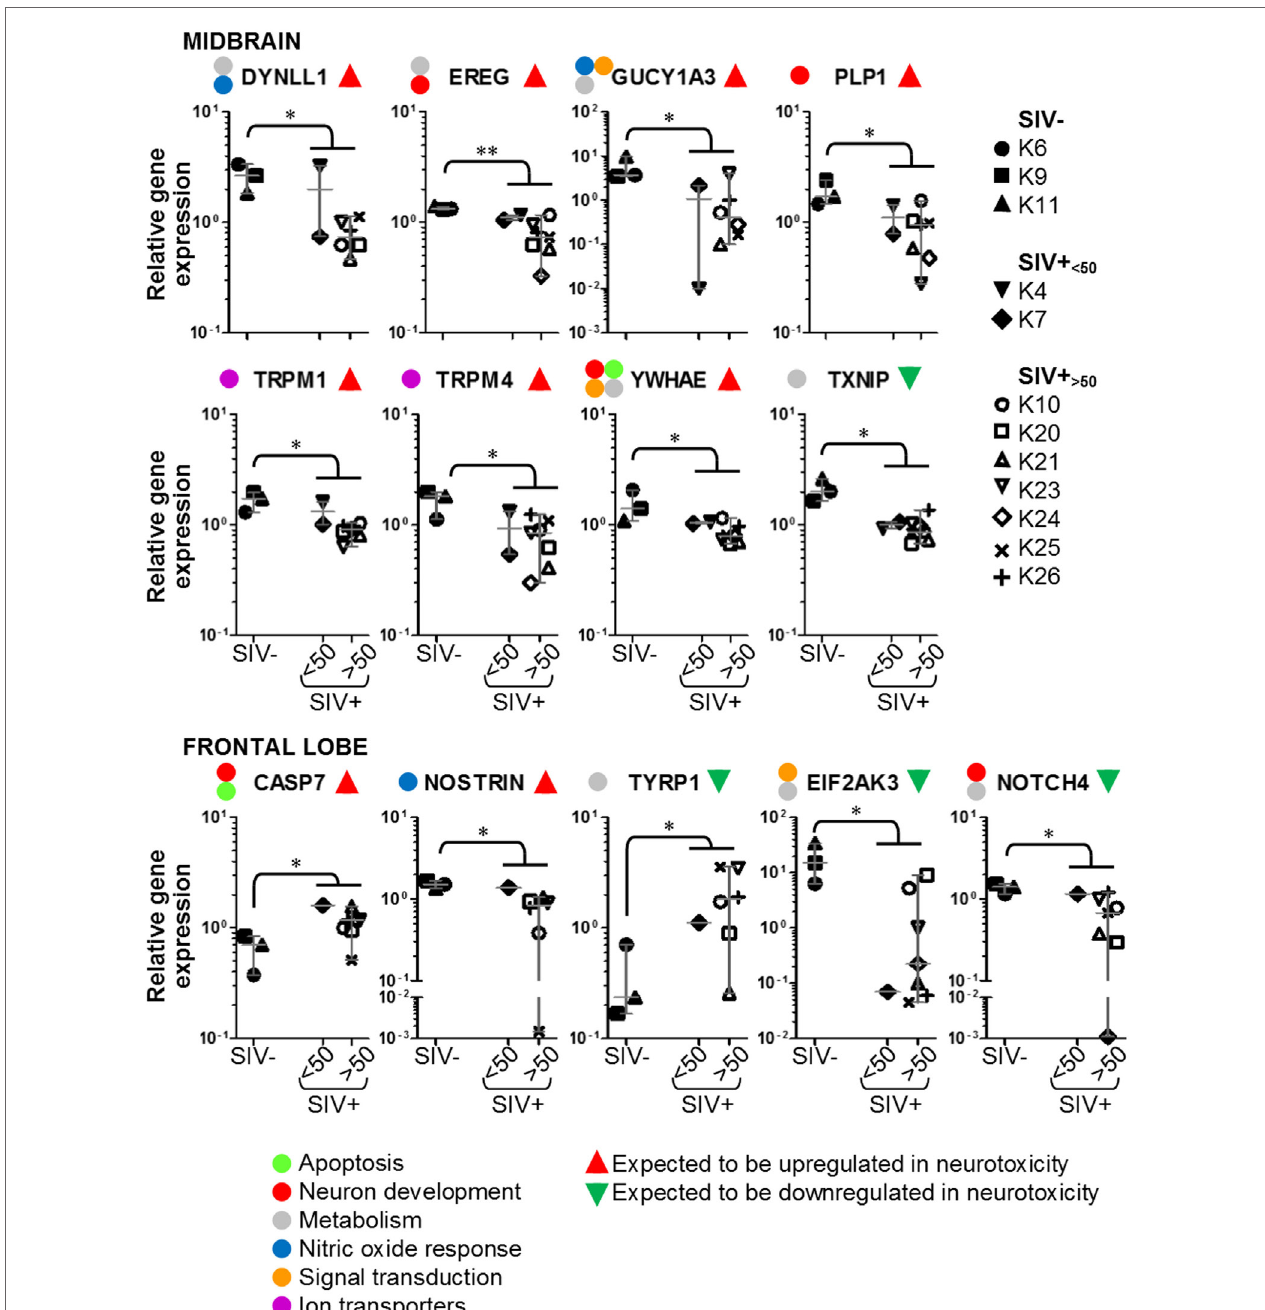
FigUre 6 | Details of neurotoxicity genes that are upregulated or downregulated in simian immunodeficiency virus (siV)-infected macaques . Plots showing relative expression of the genes in the red and green areas of Figure 5 for uninfected (SIV − ), SIV-infected aviraemic (SIV + < 50 ), and viremic (SIV + > 50 ) animals. All data are normalized against the median for all 12 animals. Each symbol indicates one animal as detailed in the legend; the legend refers to data from both midbrain and frontal lobe; horizontal gray lines within graphs indicate medians, and vertical gray lines show the interquartile ranges (* P < 0.05; ** P < 0.01).